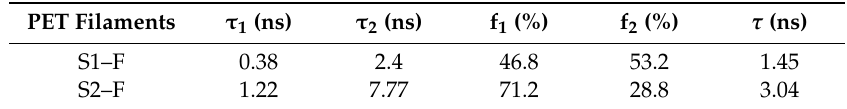
Table 2. The average lifetime τ values along with fitting parameters ( τ 1 and τ 2 with their corresponding fraction f 1 and f 2 ) of the total decay for both